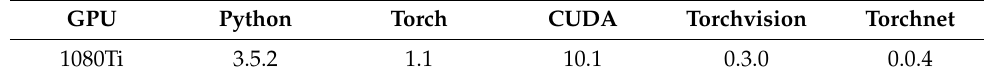
Table 4. Hardware and software environments.